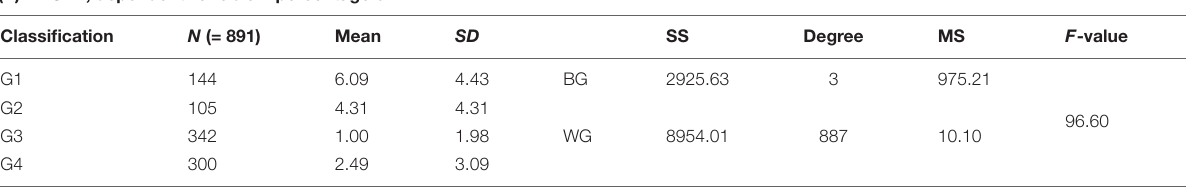
TABLE 8 | ANOVA and post hoc analysis for the manufacturing